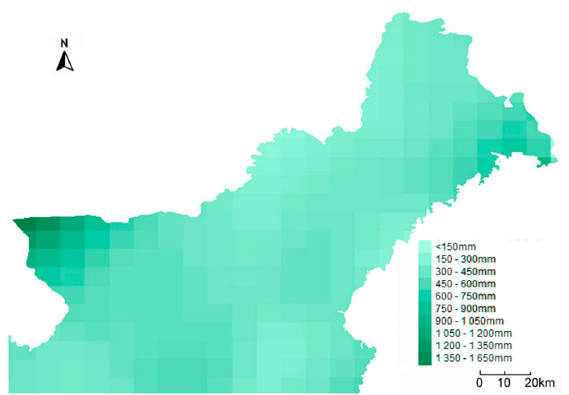
Figure 17. The map of average annual runoff depth evaluated for 50 years in the Tumen River Basin (DPR Korea side).